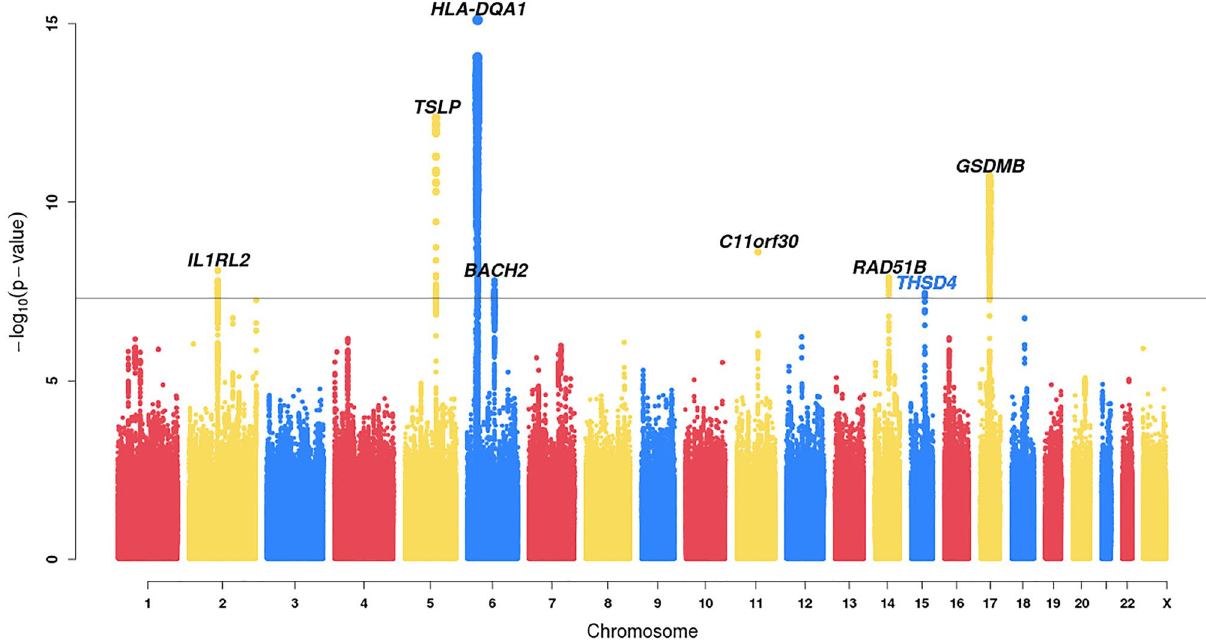
Figure 1. Manhattan plot of common variants (MAF > 1%) associated with asthma risk in this GWAS of 3,181 moderate-to-severe asthma patients and 3590 non-asthma controls. The −log 10 two-sided p-values are displayed. Variants with P < 0.01 for the differential effects test (See “Methods”) are filtered out. See Supplemental Fig. S2 for a corresponding plot which includes all variants. The black line indicates the genome-wide significance threshold of 5 × 10 –8 . Previously reported loci are labeled in black, the novel locus is labeled in blue.